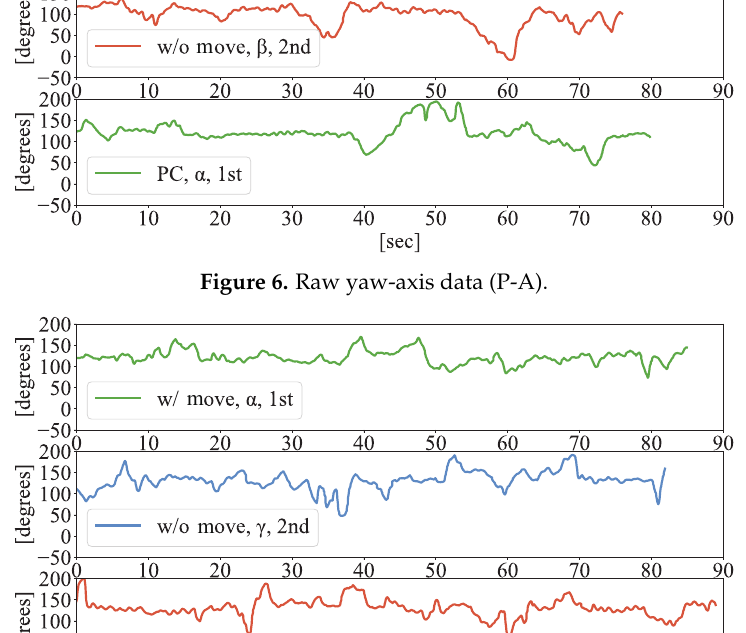
Figure 6. Raw yaw-axis data (P-A).